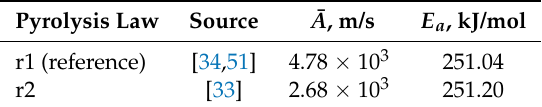
Table 5. Activation energies and pre-exponential constants for different HDPE pyrolysis laws (Equation